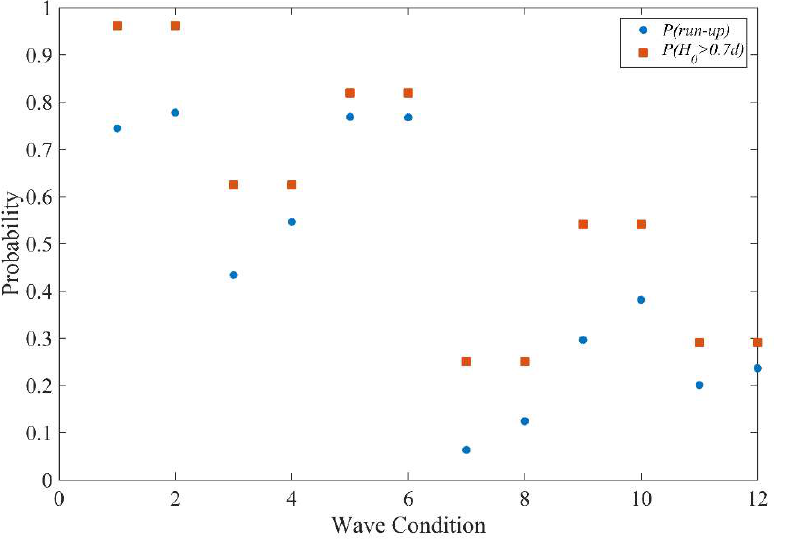
Figure 13. Comparison between possibility of wave run-up occurrence and possibility of incoming wave height exceedance in each tested wave conditions.